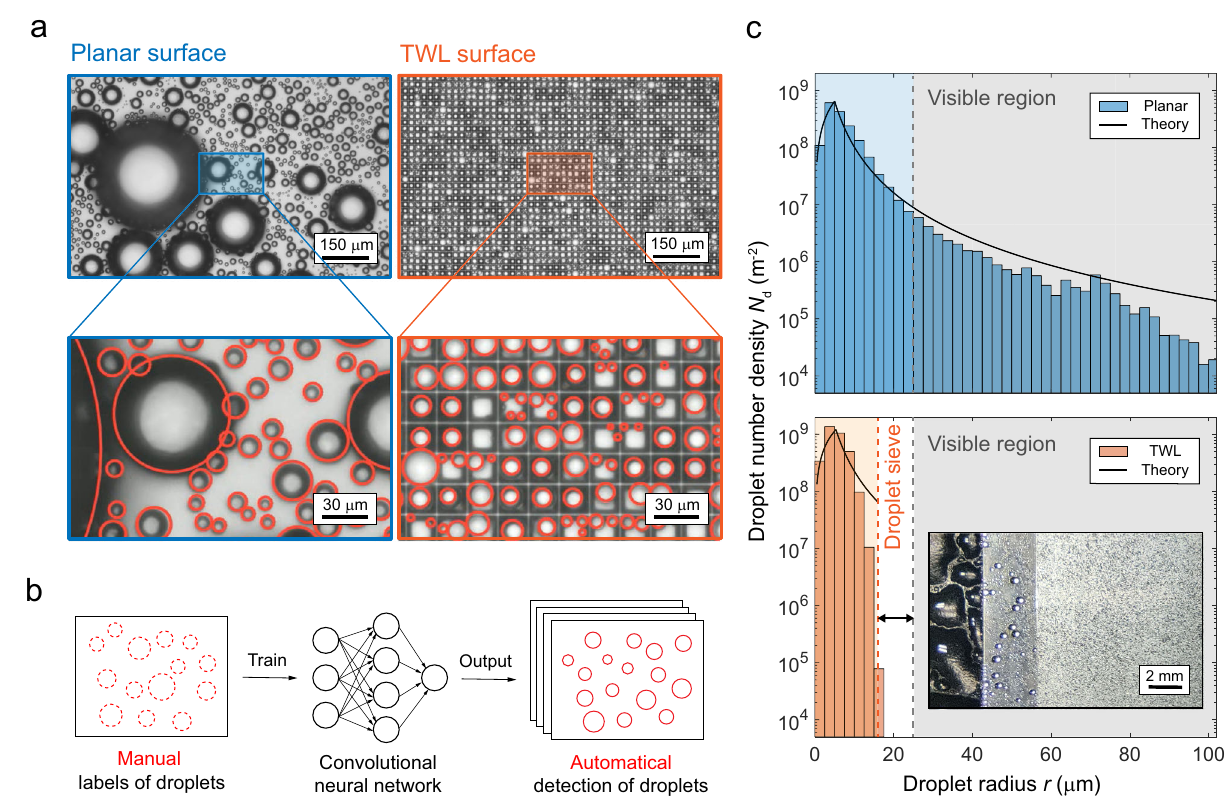
Fig. 2 | Breath fi gures on the planar and TWL surfaces. a Breath fi gures on both surfaces shot using a ×10 objective. Magni fi ed images of corresponding local breath fi gures are also given. Red circles are the detection results made by our convolutionalneural network (CNN). b Illustrationofthe construction of the CNN. ManuallymadelabelsareusedtotraintheCNN.Aftertrainingandadjustments,the CNNcan help detecta series of images automatically. c Distribution of the droplet radii.Barsrepresentthenumberdensityofdropletsinevenlyspacedradiusranges